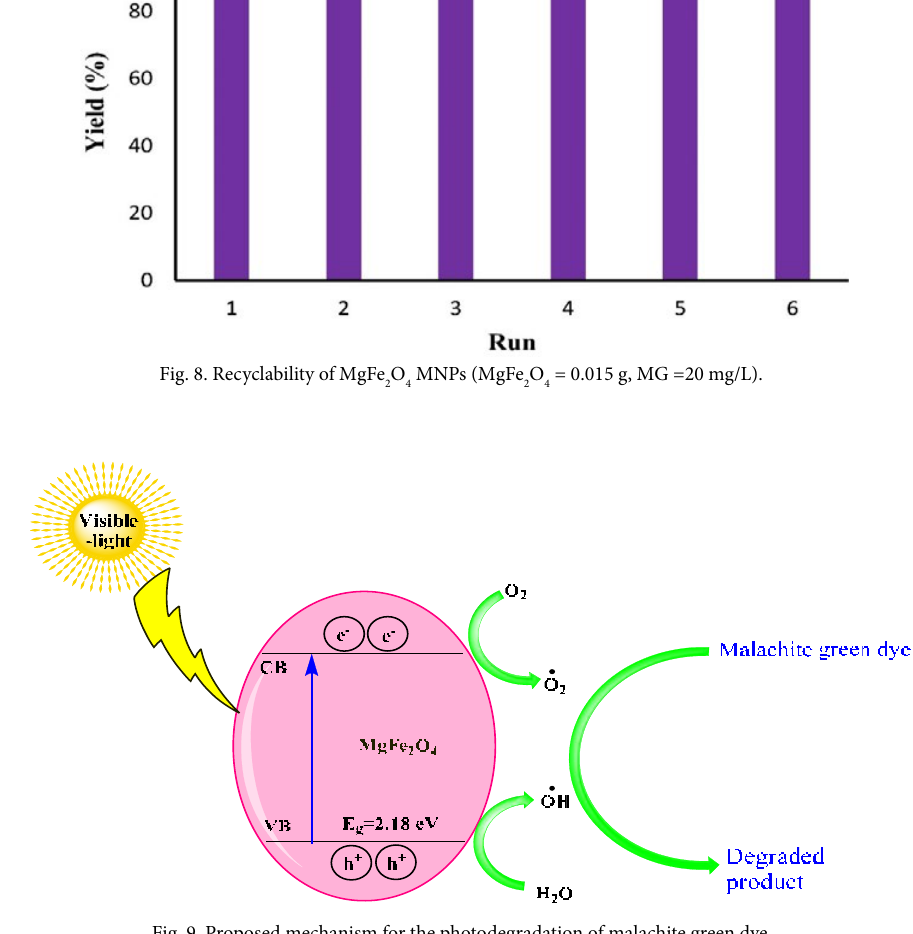
Fig. 9. Proposed mechanism for the photodegradation of malachite green Figure 9. Proposed mechanism for the photodegradation of malachite green dye